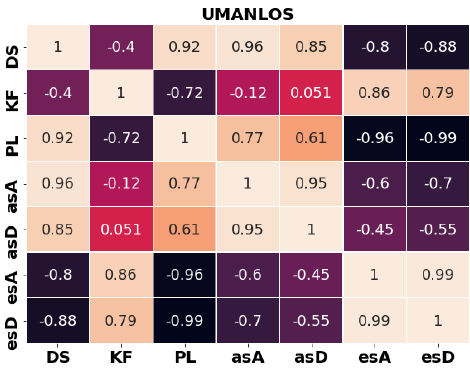
(h) After normalization for UMa NLoS. Figure 5. Correlation matrices of the inter-parameter correlations of different scenarios.